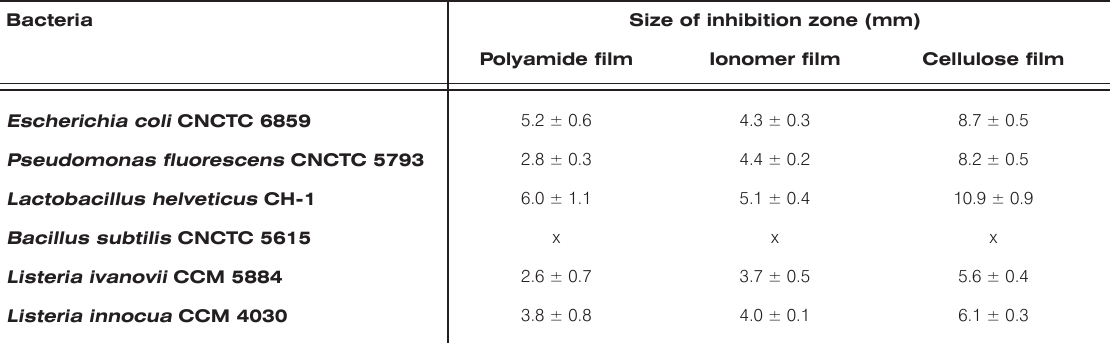
Table 4. Size of inhibition zones formed around the films with immobilized GOX.